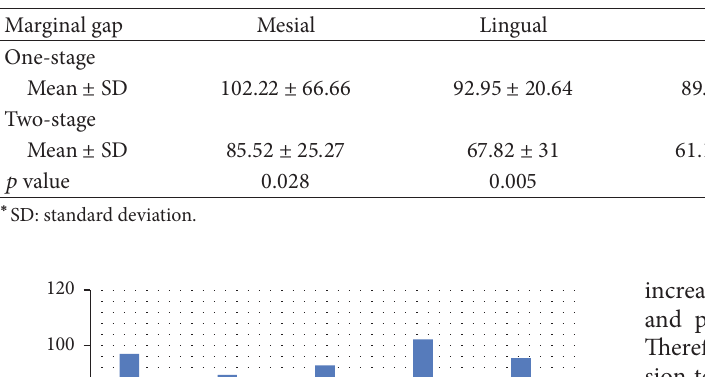
Table 1: Descriptive statistics and significance level of independent 𝑡 -test.